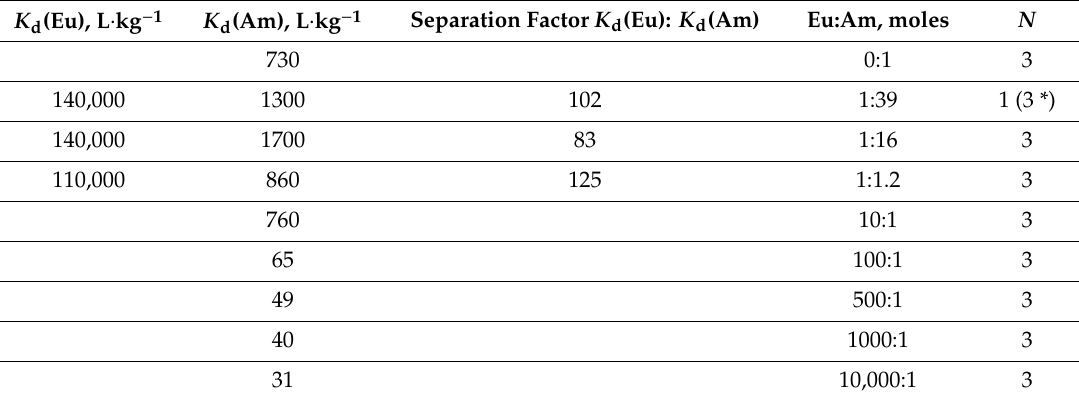
Table 3. Distribution coe ffi cient for Eu and Am for selected Eu:Am molar ratios for ZrP in nitric acid containing sodium nitrate (pH eq